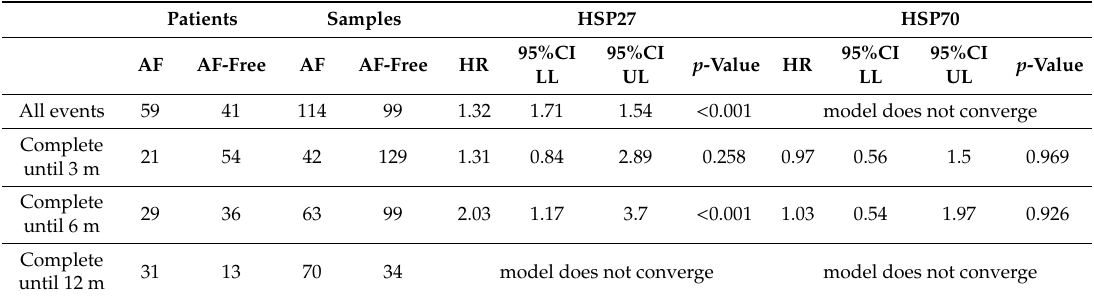
Table 2. Outcomes joint modeling of AF recurrence in relation to HSP levels, and sensitivity analyses.